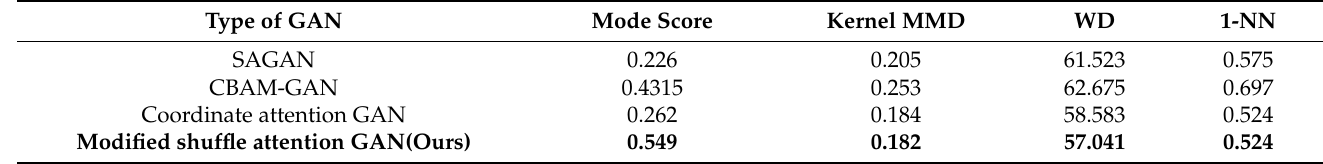
Table 2. Other quantitative evaluation index of generated pictures of different GAN models. Type of GAN Mode Score